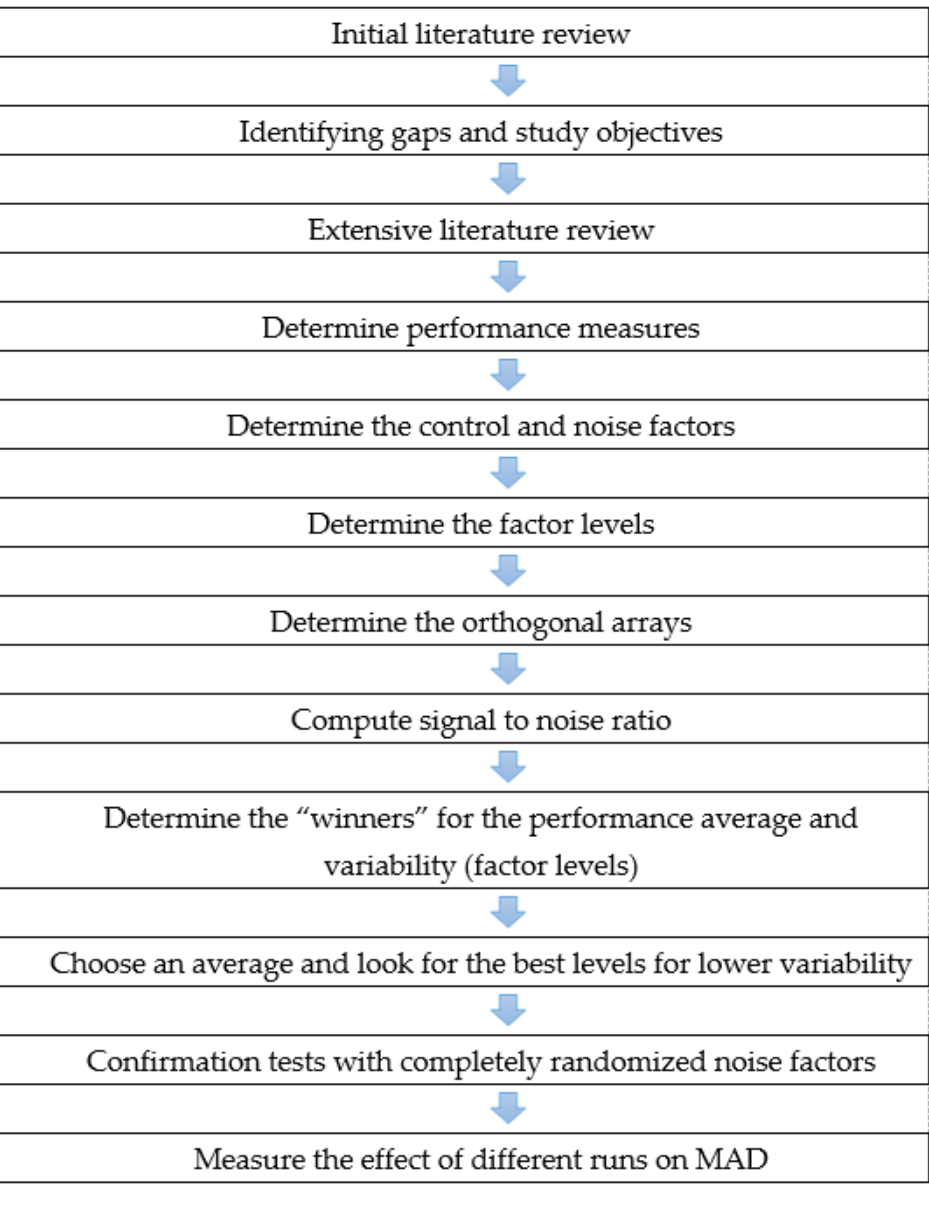
Figure 1. Study Methodology.